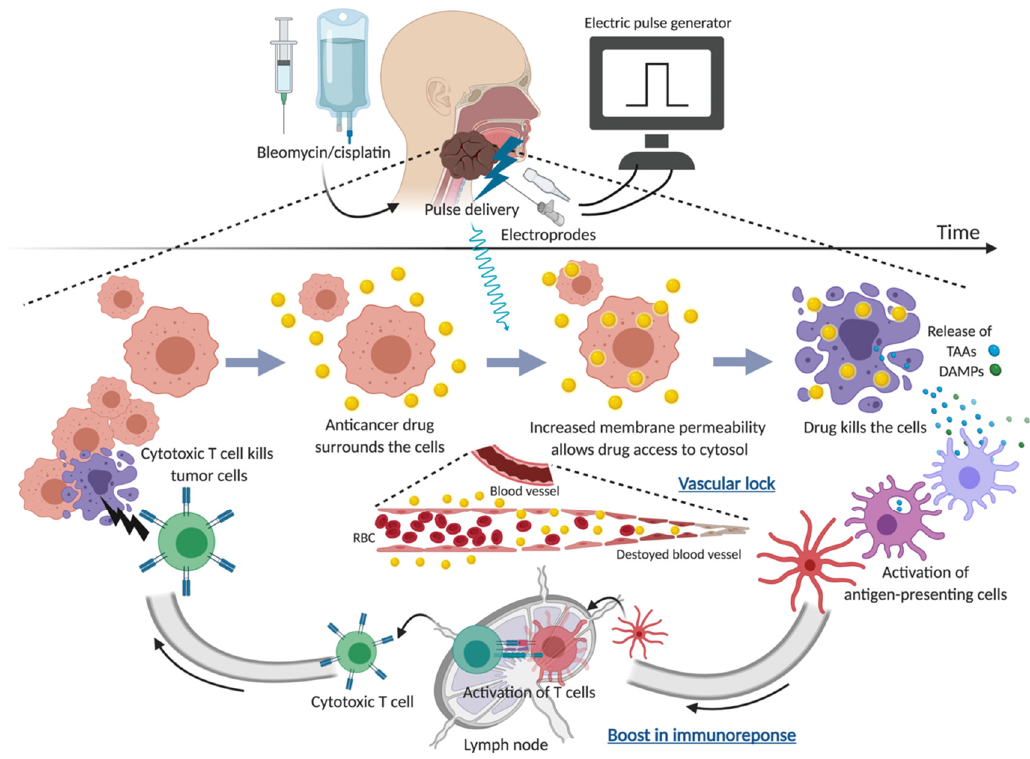
Figure 1. The concept of electrochemotherapy in HNC. TAAs, tumor-associated antigens; DAMPs, damage-associated molecular pathways.